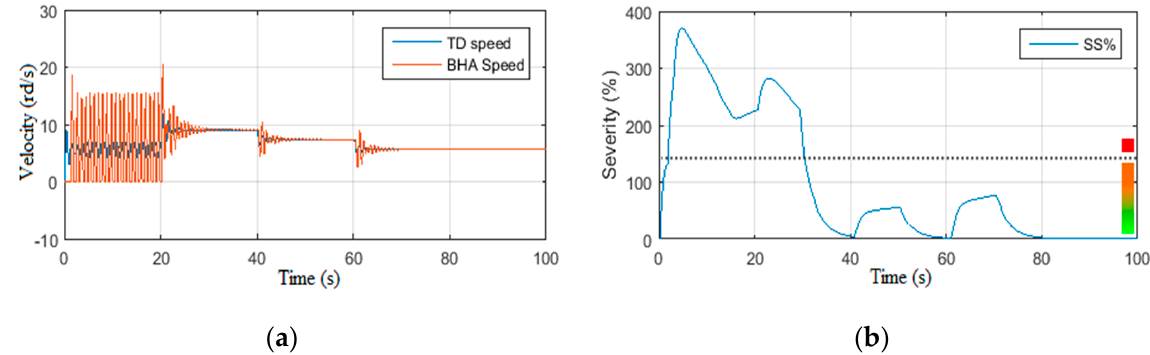
Figure 7. Scenario 1.2 open loop responses: ( a ) Rotational Velocities of Top drive and Drill bit, ( b ) Stick-slip severity.